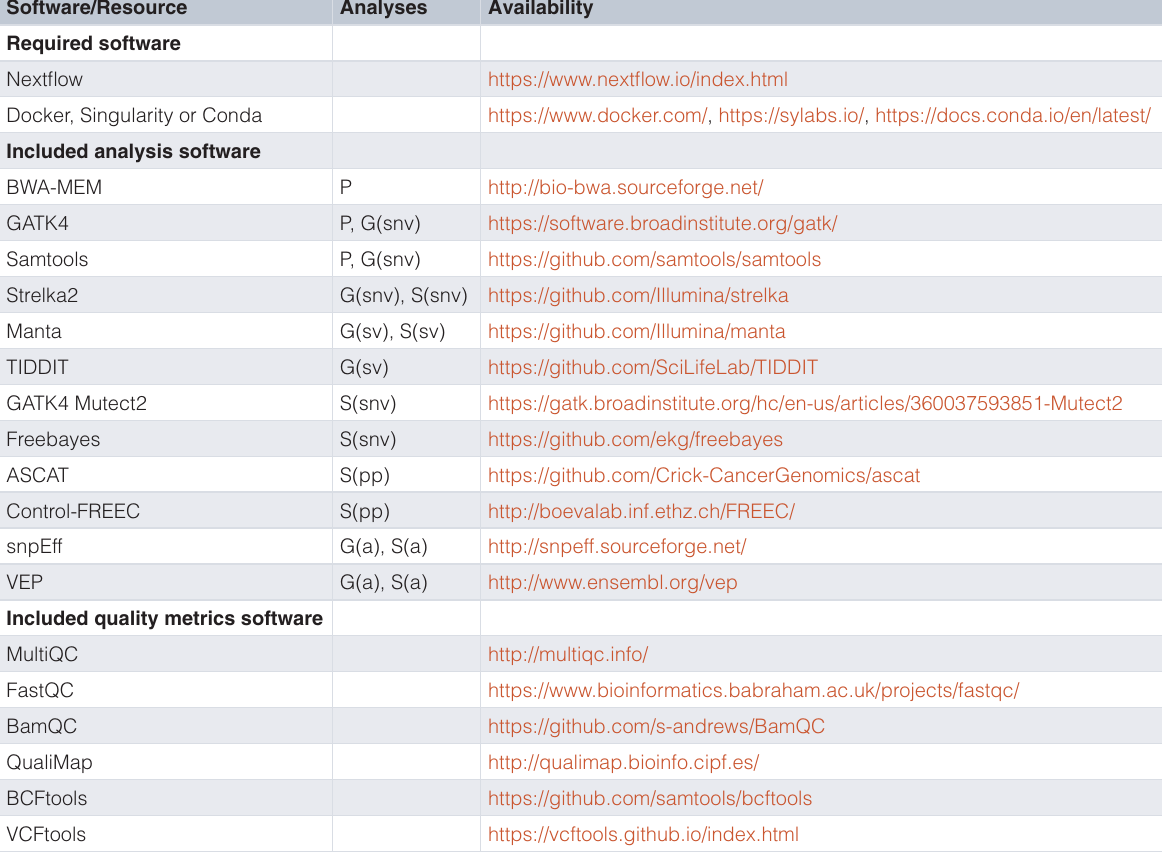
Table 1. Software required and implemented in Sarek. A list of all the software required and currently implemented in Sarek. All analysis and quality metrics software are installed automatically when Sarek is launched. P, Preprocessing; G, Germline; S, Somatic; snv, Single-nucleotide variants and small indels; sv, Structural variants; pp, Ploidy and sample purity; a, Annotation.